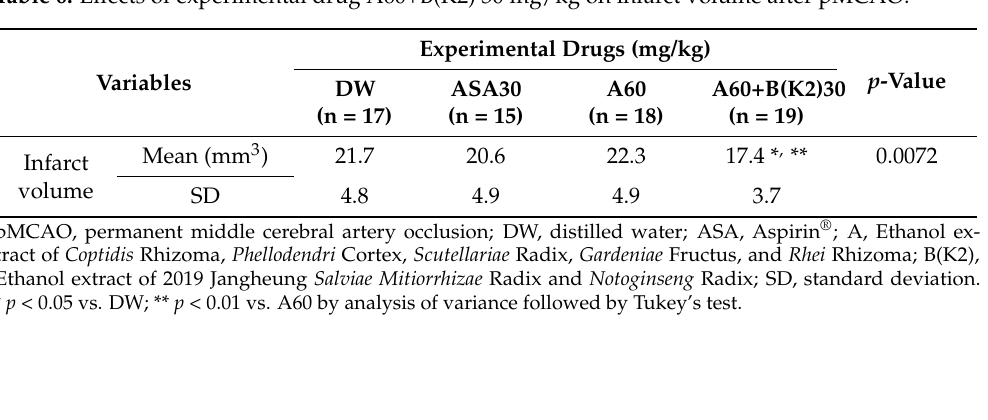
viae miltiorrhizae Radix and Notoginseng Radix. Data represent means ± standard deviation. * p < 0.05